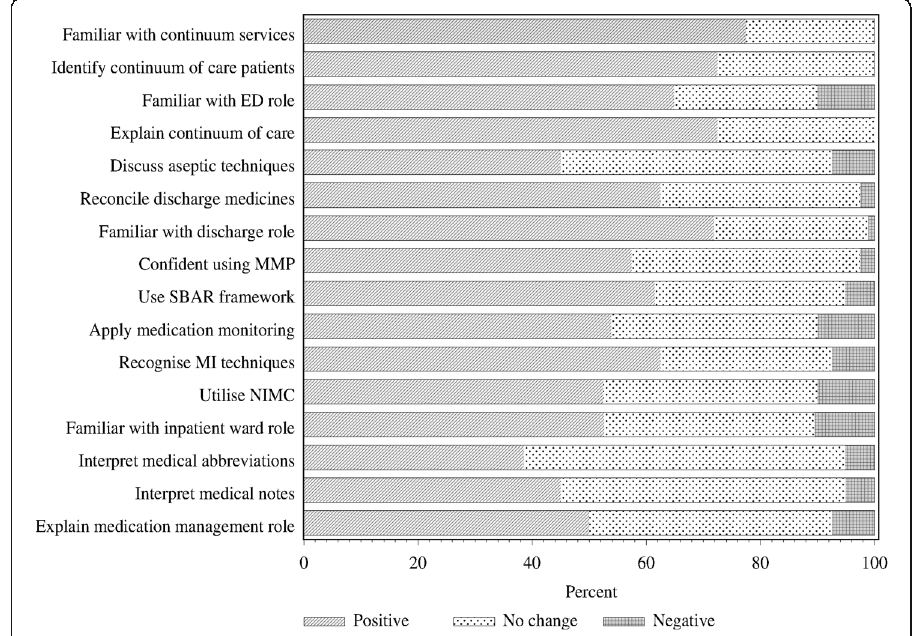
Fig. 1 Changes between pre- and post-test data for confidence with medication management roles and processes. Bars represent changes to students ’ responses to agree/strongly agree, neutral and disagree/ strongly disagree